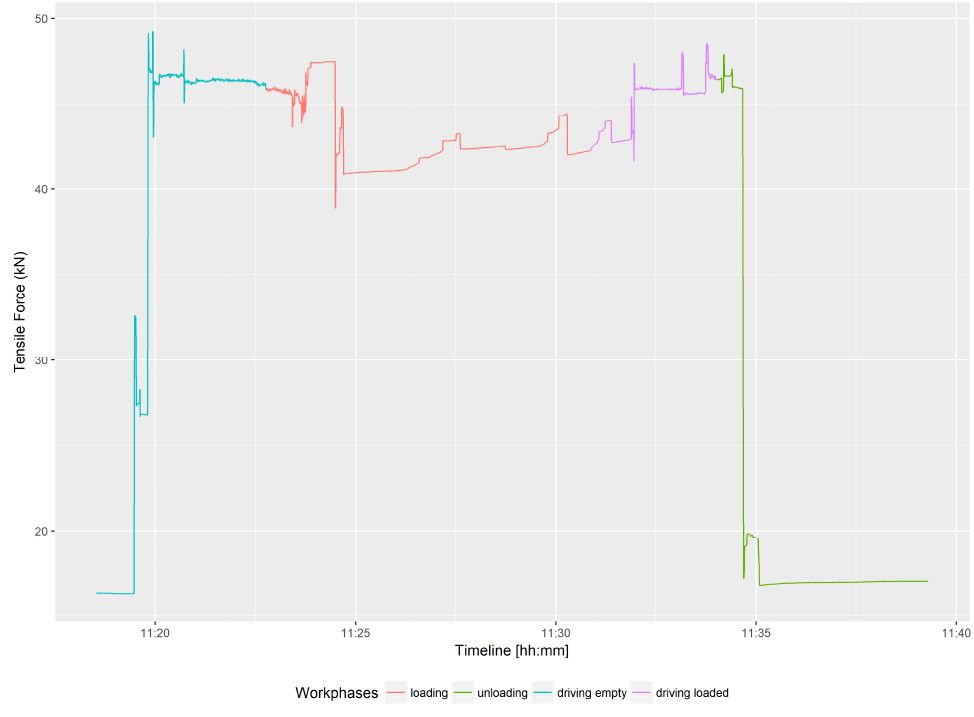
Figure 12. Tensile force graph showing one cycle of the observed forwarder over time with the assigned working phases.